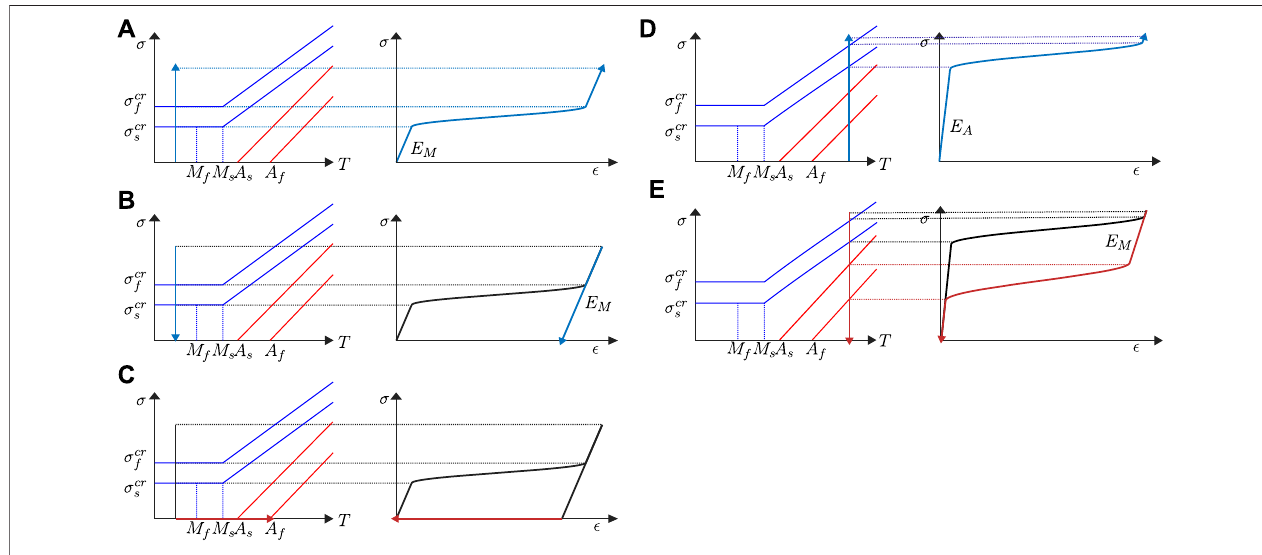
FIGURE 3 | Examples of stress-strain relation of shape memory effect: (A – C) and of pseudoelastic behavior: (D,E) , the fi gure is inspired by (Saputo et al., 2020).